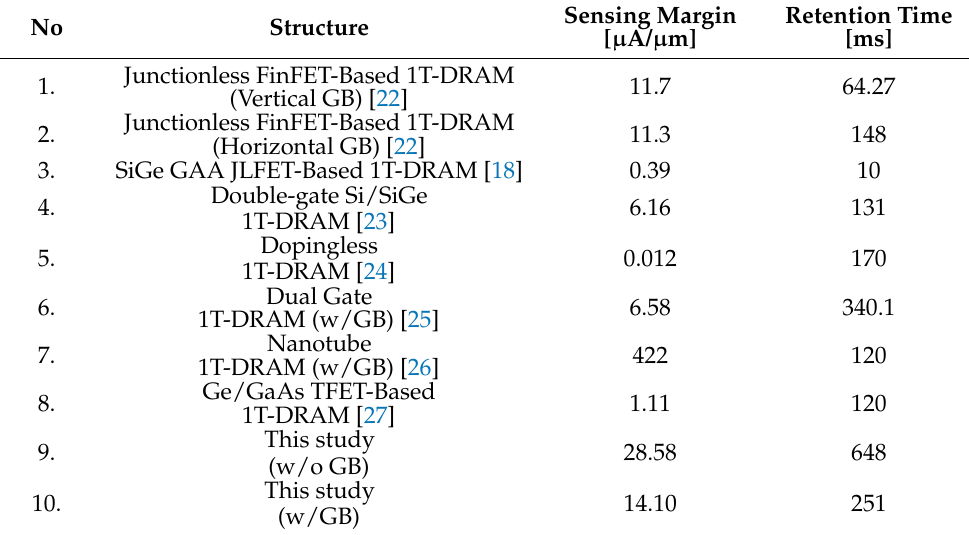
Table 4. Memory performances of various 1T-DRAM reported in the literature.